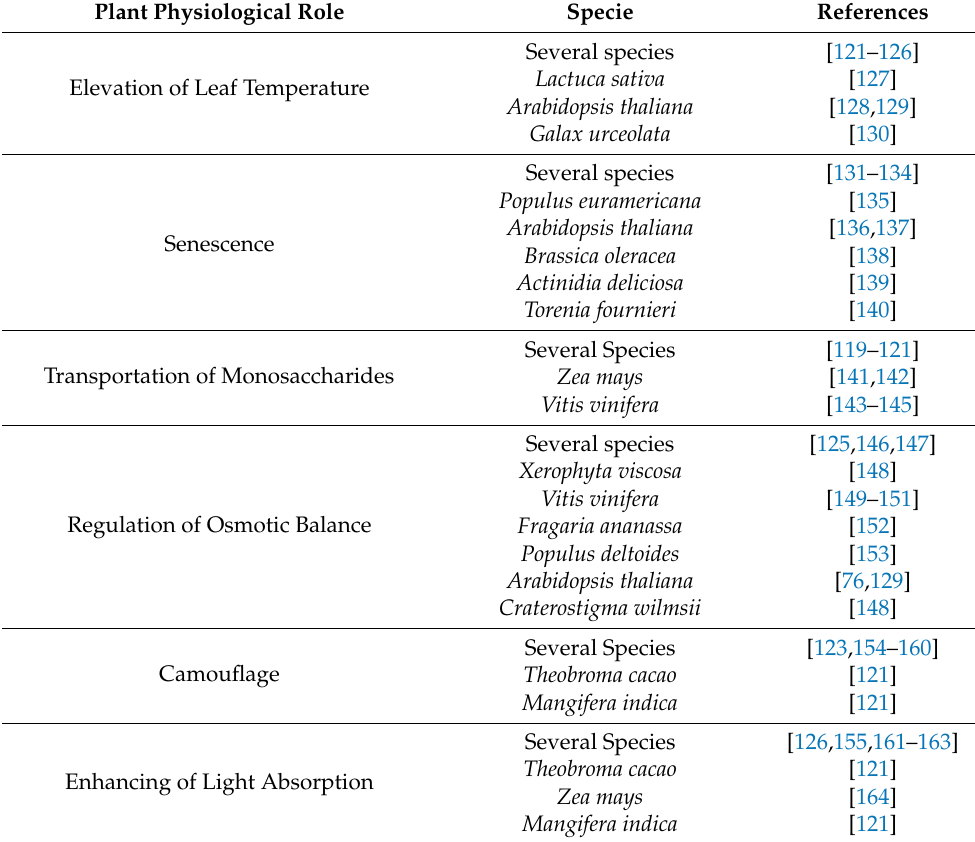
Table 2. Documented plant physiological processes in which anthocyanins are